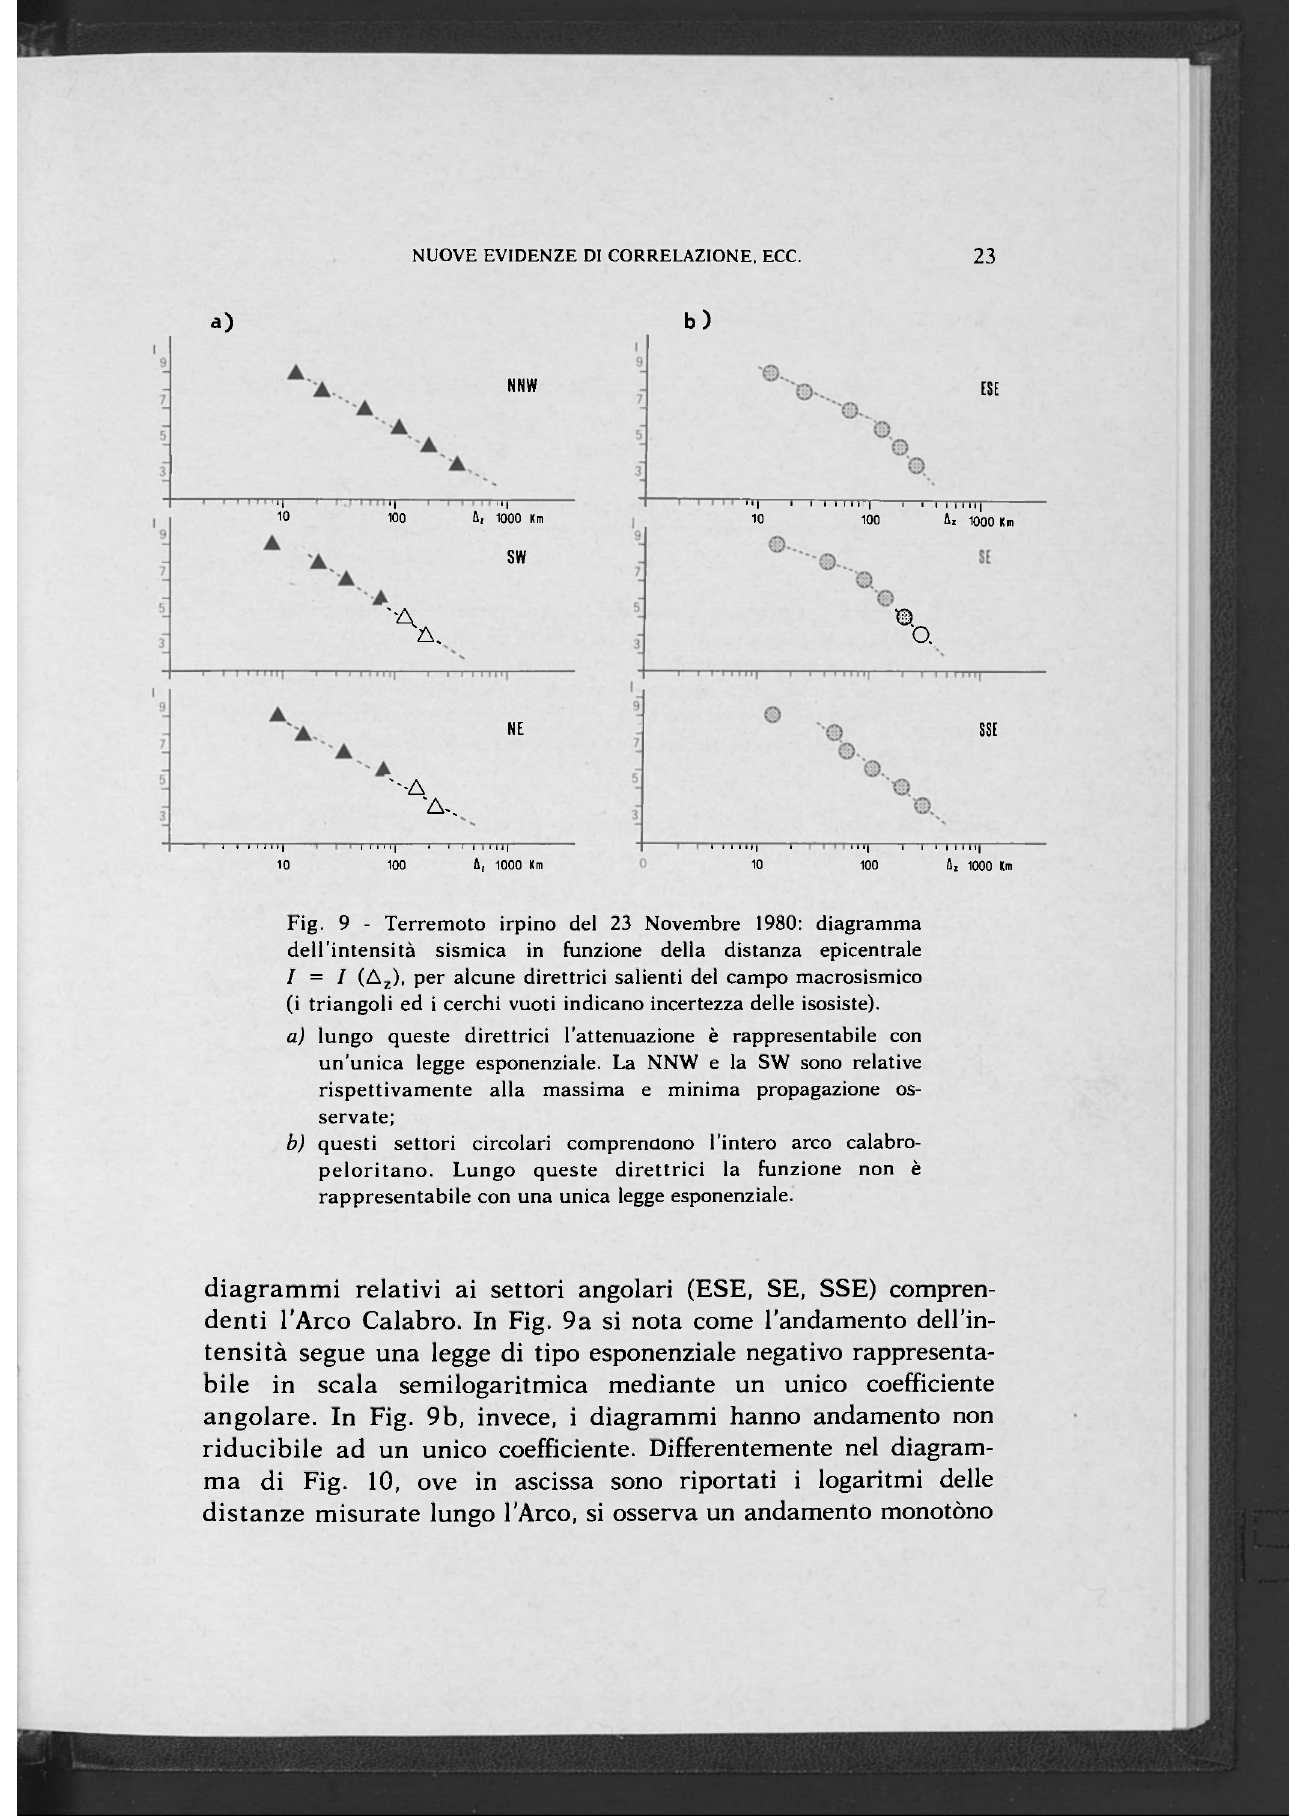
Fig. 9 - Terremoto irpino del 23 Novembre 1980: